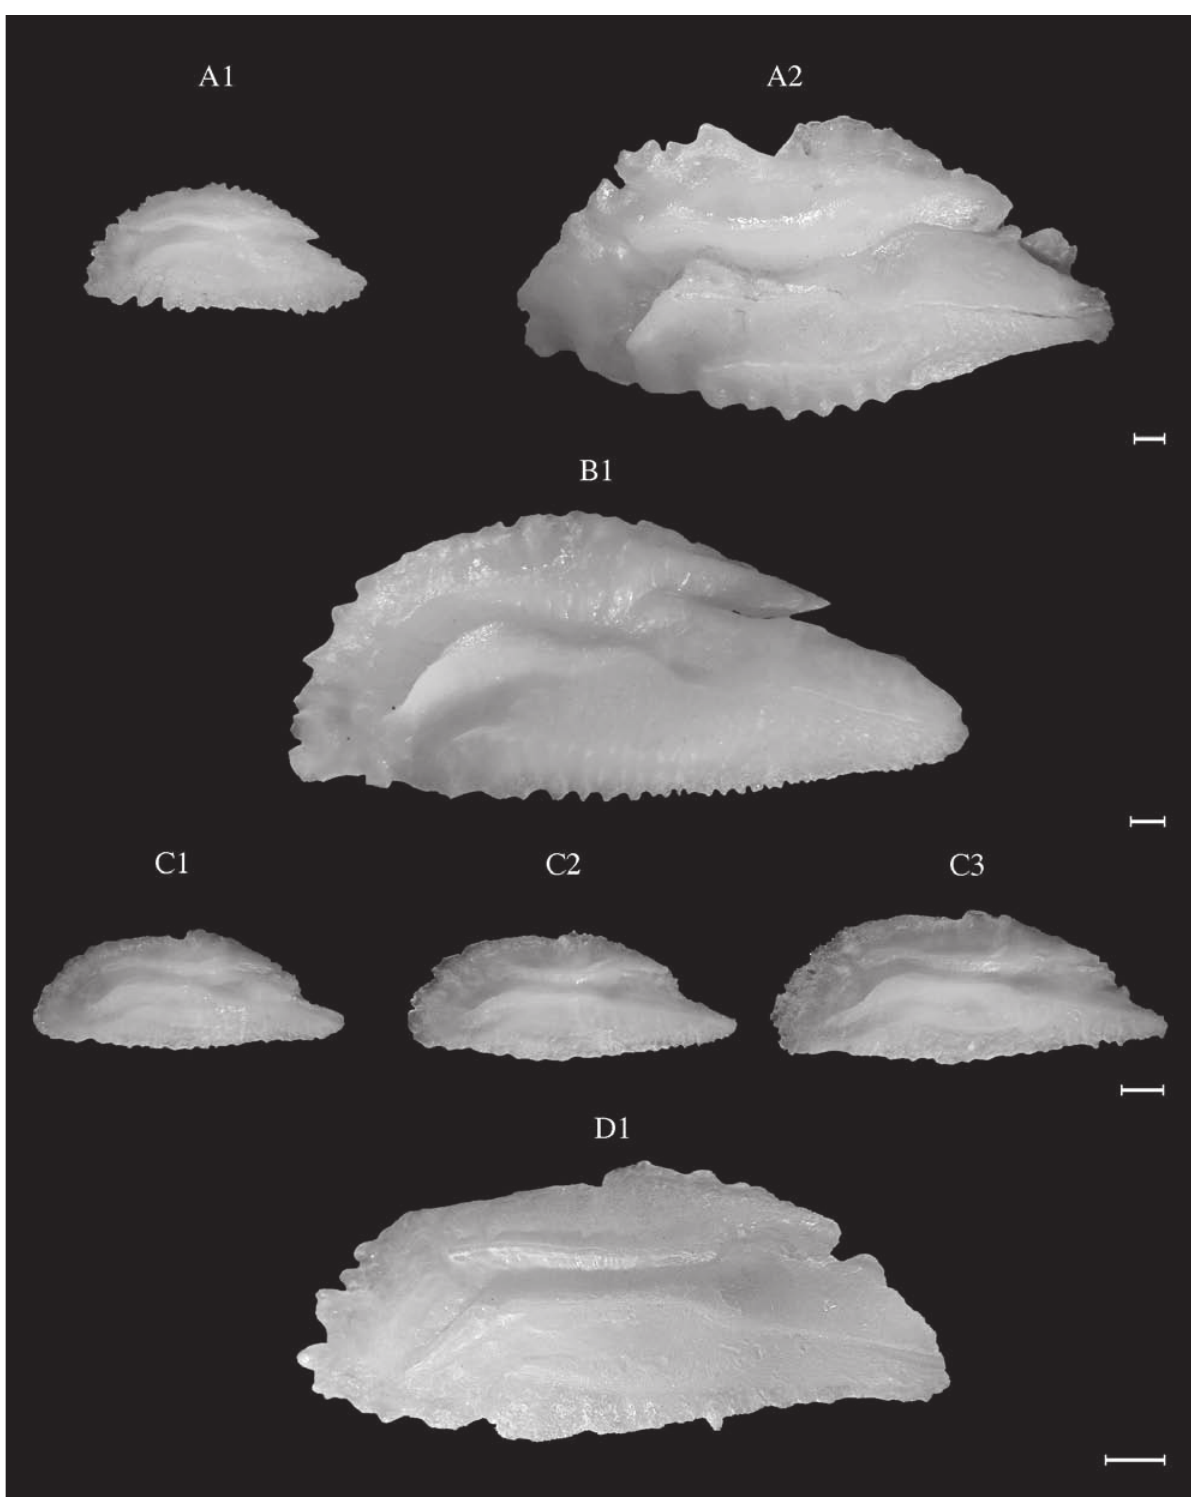
Fig. 48. – Epinephelus marginatus (CEA). TL: A1, 31.5 cm; A2, 78.5 cm. Epinephelus tauvina (CEA). TL: B1, 70.2 cm. Mycteroperca fusca (CEA). TL: C1, 35.5 cm; C2, 36.0 cm; C3, 40.0 cm. Mycteroperca rubra (CEA). TL: D1, 44.7 cm. Scale bar = 1